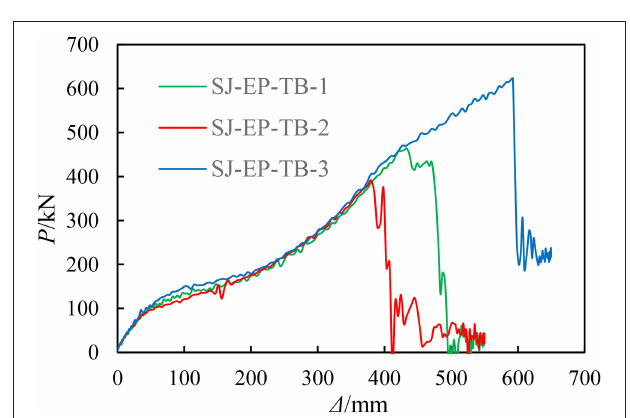
reaches the ultimate bearing capacity, its vertical displacement ( 1 max ) and maximum resistance ( P max ) are 433.10 mm and 463.91 kN, respectively, which is 13.94 and 18.61% higher than that of SJ-EP-TB-2. The diameter of the through bolt of SJ- EP-TB-3 is the largest among the three, and its failure mode turns to a steel beam failure. The top resistance at the end of bending mechanism ( P f ) is 111.84 kN, which is 17.18% higher than that of SJ-EP-TB-2. When SJ-EP-TB-3 reaches and maximum resistance ( P max ) are 592.45 mm and 623.08 of